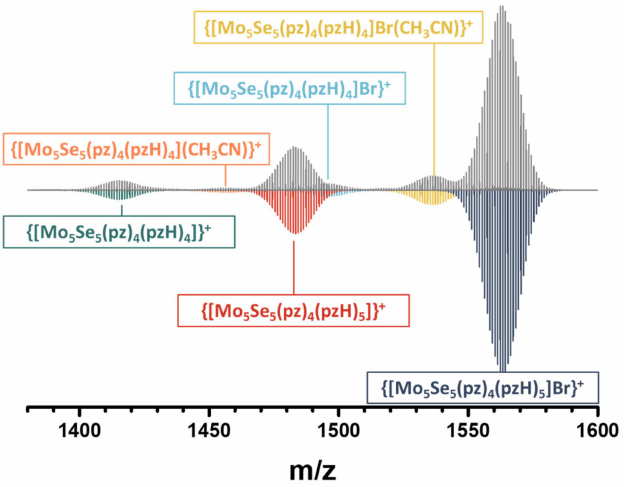
Figure 7. Fragment of HR-ESI-MS spectrum of solution of Mo 5 ox in acetonitrile (gray) and simula- tions of cluster forms